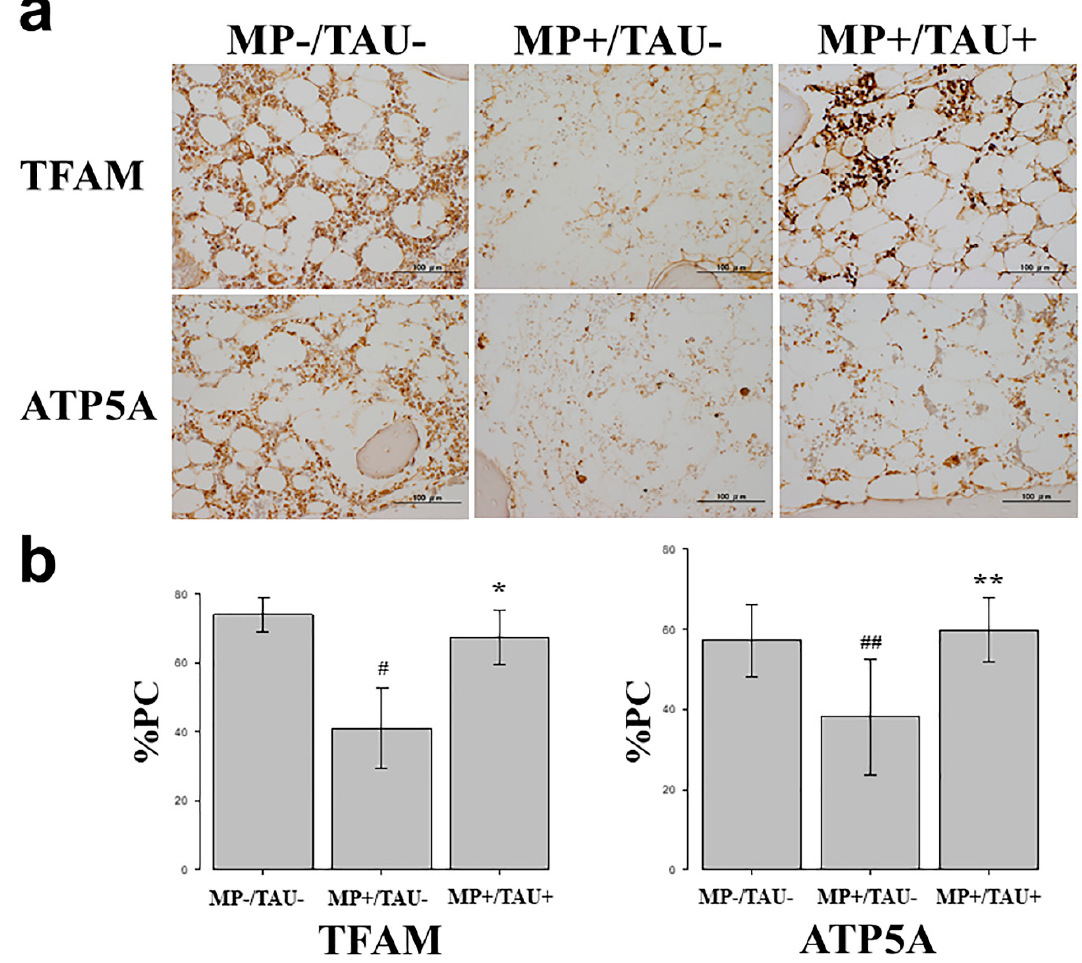
Figure 3. TFAM and ATP5A positive cell rate after taurine administration in a glucocorticoid-induced rabbit osteonecrosis model. ( a ) Immunohistochemical study of TFAM and ATP5A. Scale bar: 100 µ m. ( b ) Graph indicates percentage of positive cells of TFAM and ATP5A in the indicated conditions. Columns and bars indicate means and S.E. As compared with MP − / TAU − group, in MP +/ TAU − group the numbers of TFAM and ATP5A positive cells were significantly decreased ( # p < 0.0001 vs. MP − / TAU − , ## p = 0.001 vs. MP − / TAU − ). In MP +/ TAU + group, TFAM and ATP5A levels were maintained as compared with MP − / TAU − group. (* p < 0.0001 vs. MP +/ TAU − , ** p < 0.001 vs. MP +/ TAU − ).